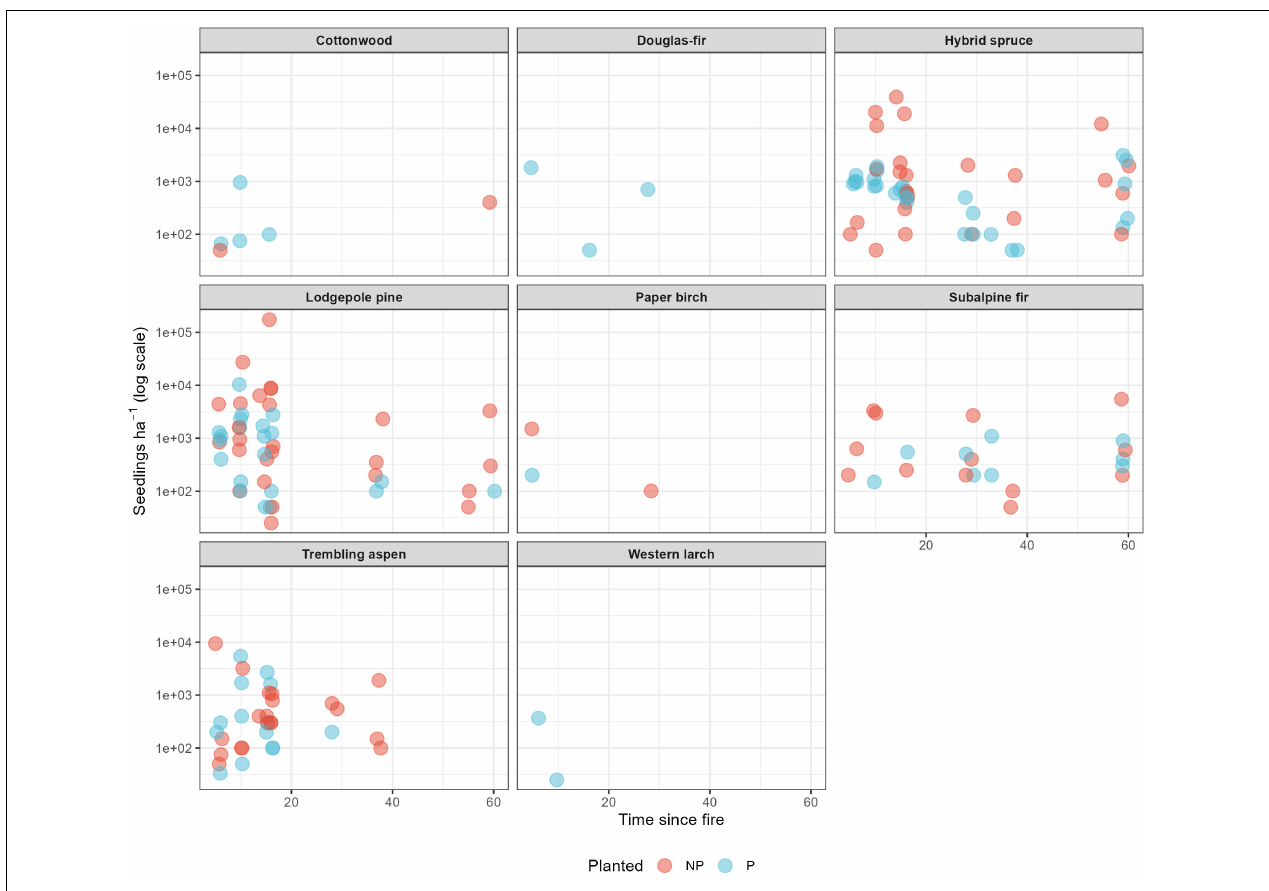
FIGURE 6 | Regeneration (trees < 1.3 m) abundance (seedlings–ha − 1 on a log scale) by species and planting treatment over time since fire.